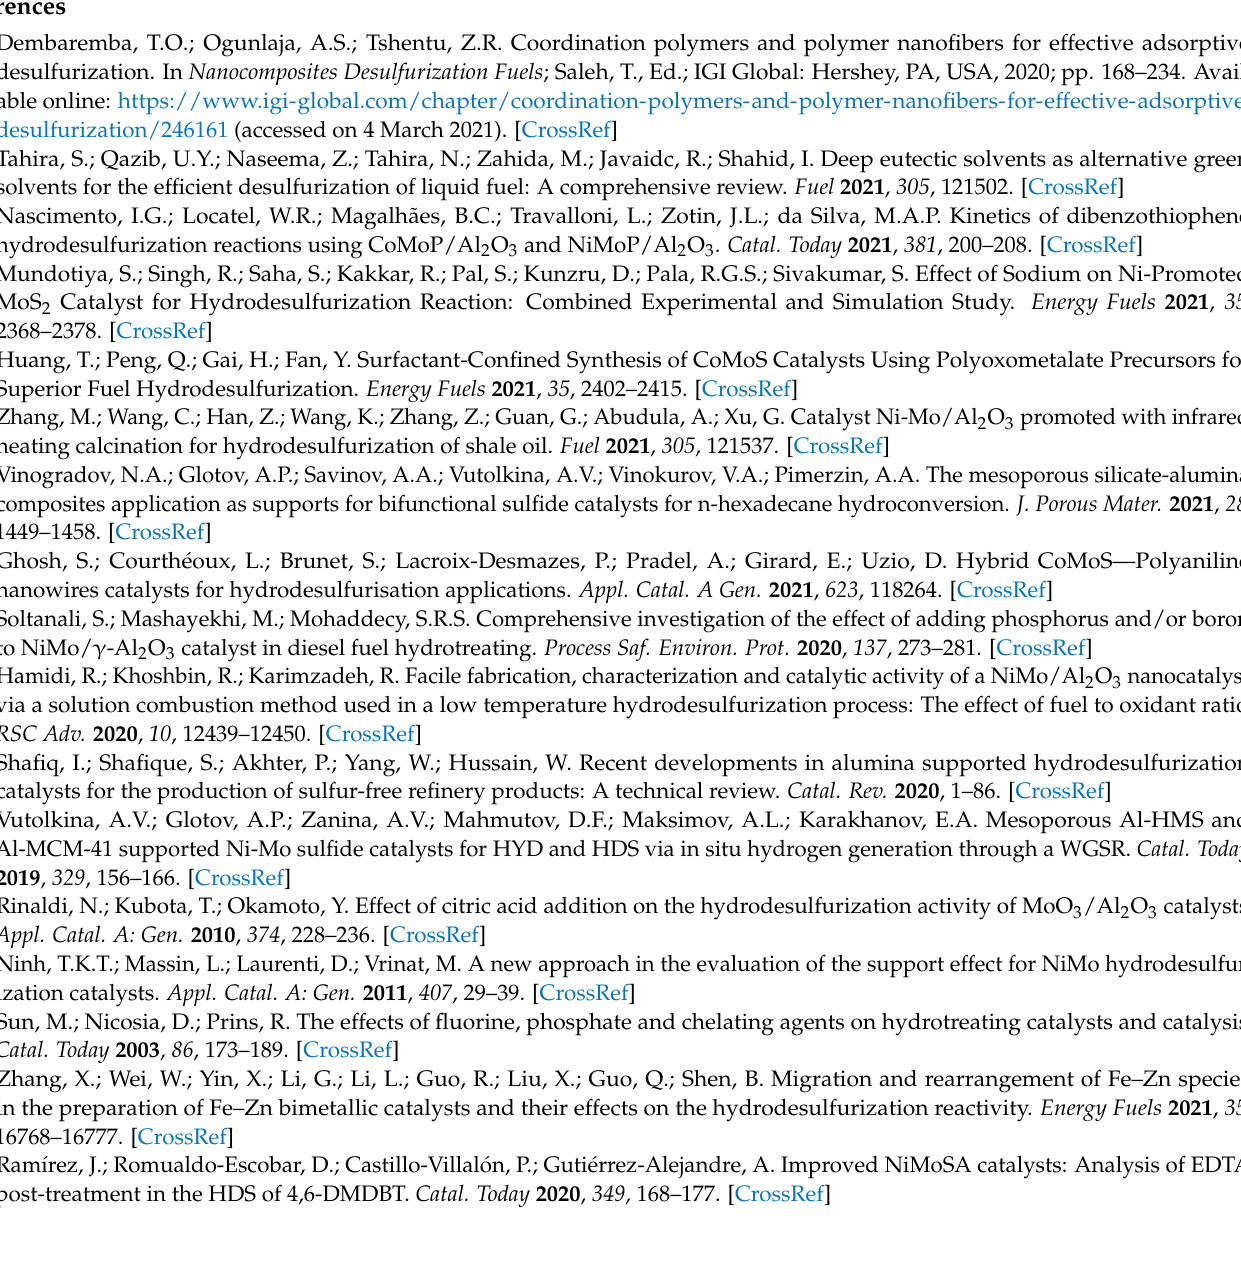
catalysts; Table S2. XPS parameters of the contributions of Rh 3d obtained for unchelated and chelated RhMo/Al 2 O 3